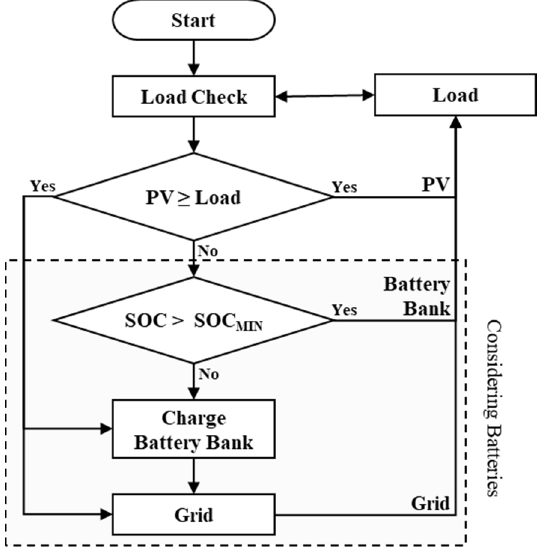
Figure 3. Control strategy for domestic PV–battery system. SOC: state of charge.